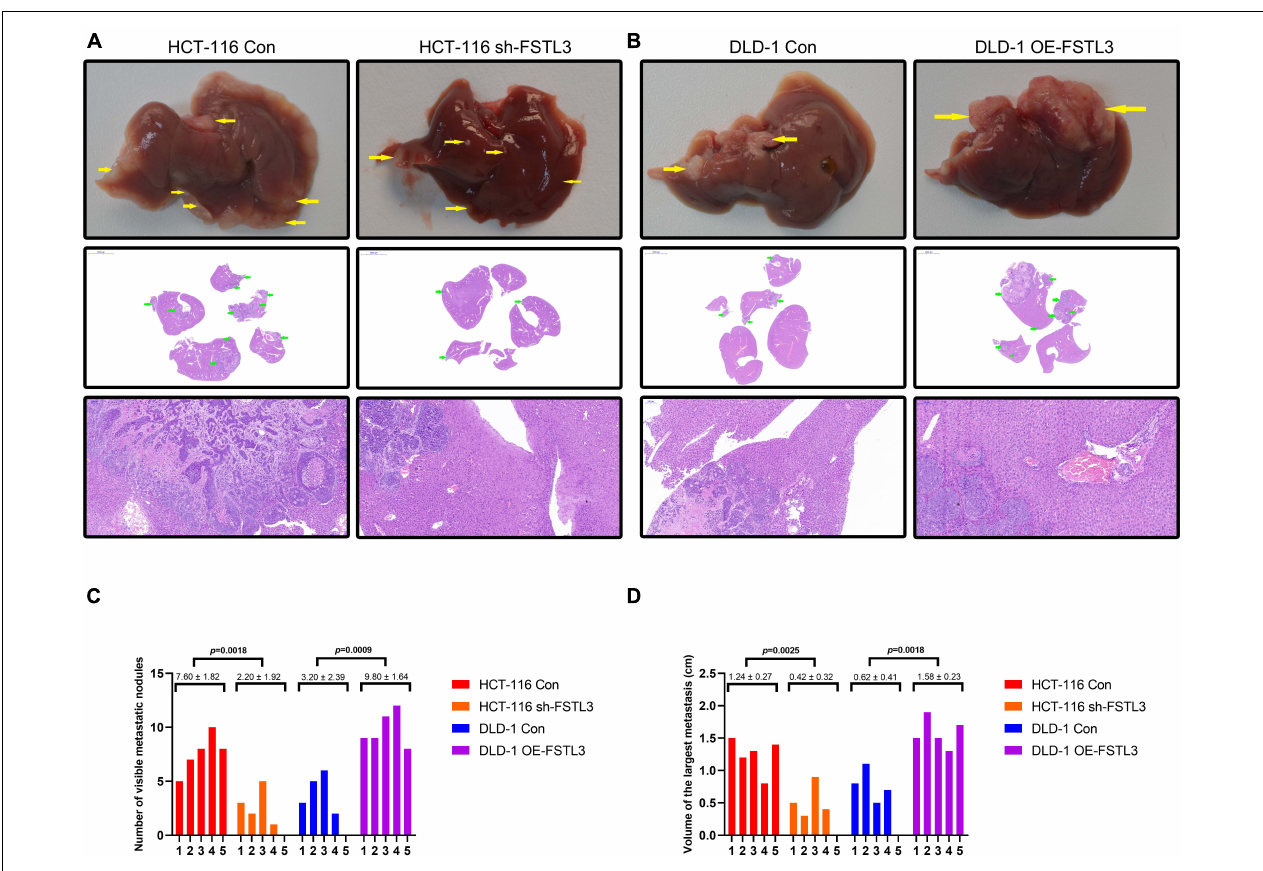
FIGURE 6 | FSTL3 enhances CRC cell metastasis in vivo . (A) Liver metastases became visible in all of the mice injected with HCT-116 control cells, and in 4 of 5 mice injected with FSTL3-depleted HCT-116 cells (scale bar, top: liver specimen; middle: 5000 µ m; bottom: 100 µ m). (B) Liver metastases were visible in all of the mice injected with DLD-1 overexpressed FSTL3 (OE-FSTL3) cells, and in 4 out of 5 mice injected with DLD-1 control cells (DLD-1 Con) (scale bar, top: liver specimen; middle: 5000 µ m; bottom: 100 µ m). (C) The numbers of hepatic metastatic nodules were notably reduced in mice injected with HCT-116 sh-FSTL3 cells and DLD-1 control cells, compared with the numbers in those injected with HCT-116 control cells and DLD-1 OE-FSTL3 cells ( p = 0.0018; p = 0.0009). (D) Volumes of the largest liver metastasis in mice injected with FSTL3-depleted HCT116 cells were significantly smaller than that with FSTL3 overexpressed cells ( p = 0.0025; p =